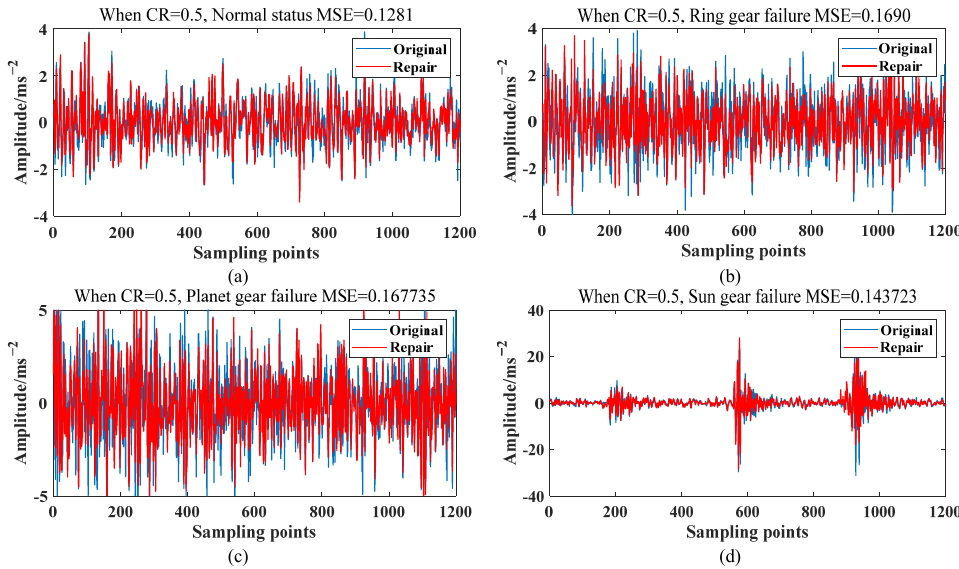
Figure 8. Compare and analyze the 95% confidence interval of MES on the four datasets with other compression reconstruction algorithms: ( a ) normal status, ( b ) ring gear, ( c ) planet gear, and ( d ) sun gear.